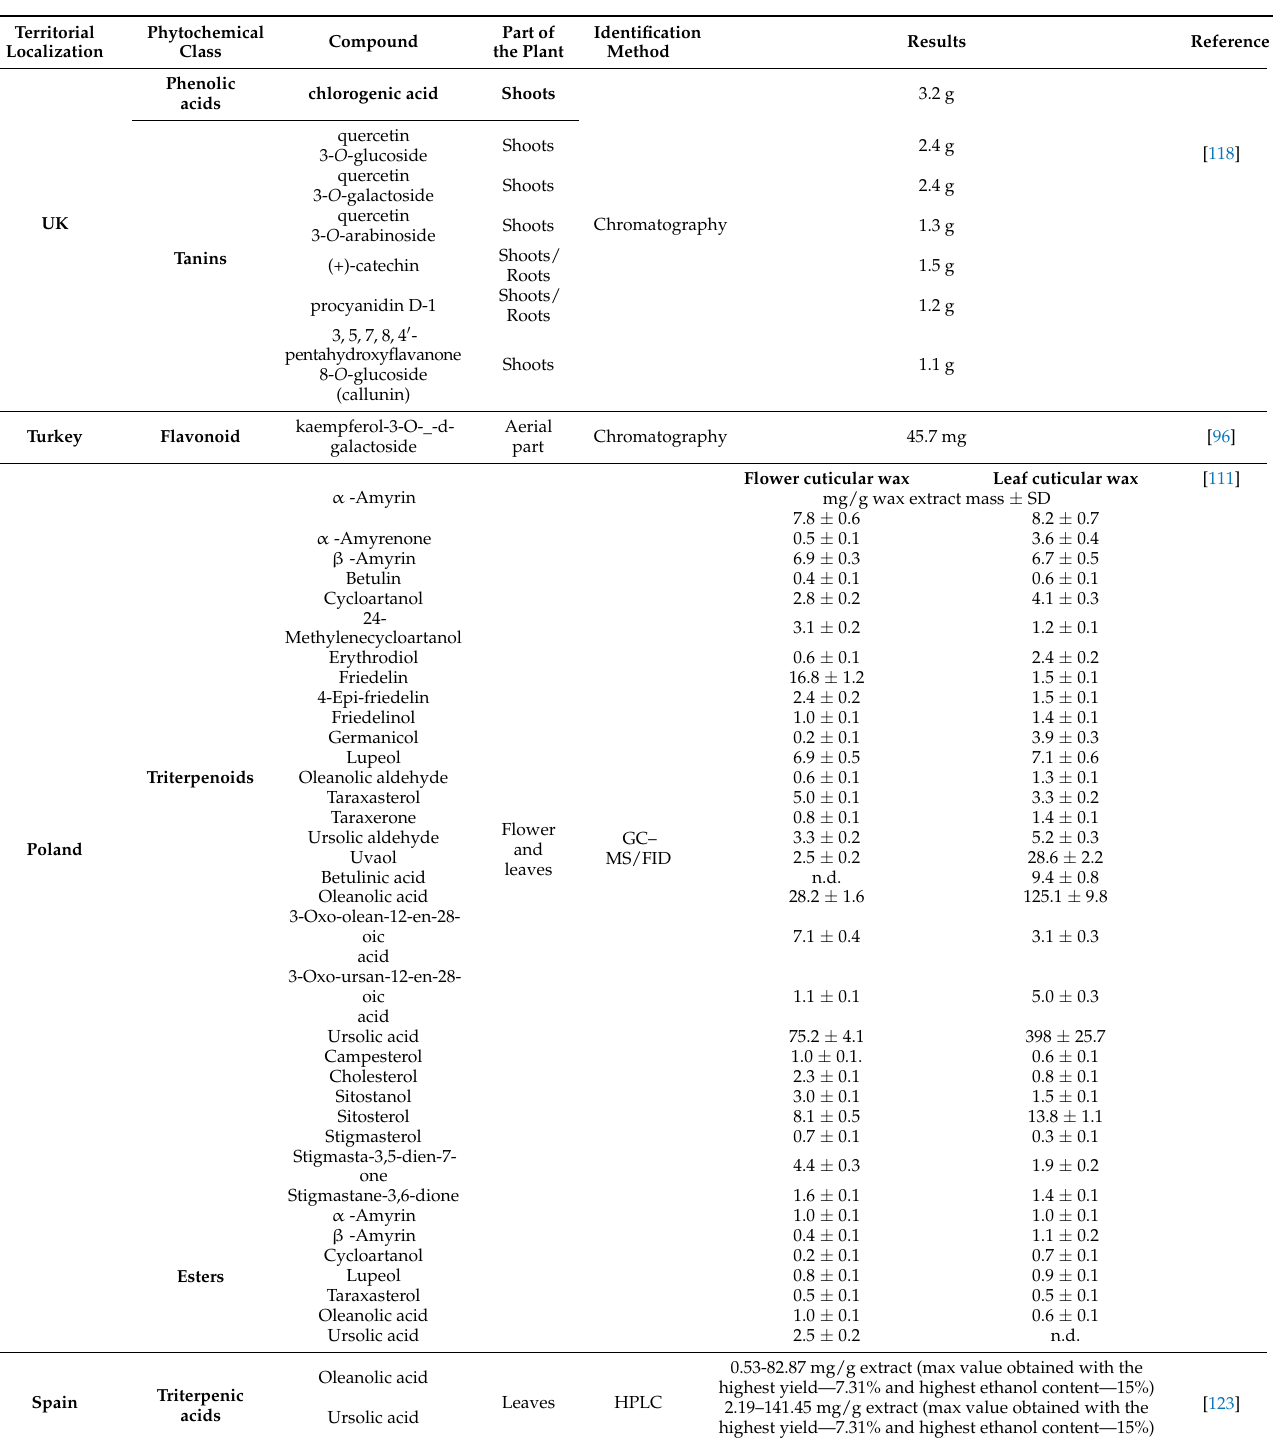
Table 2. Phytochemical profile of C. vulgaris , structure, localization and identification